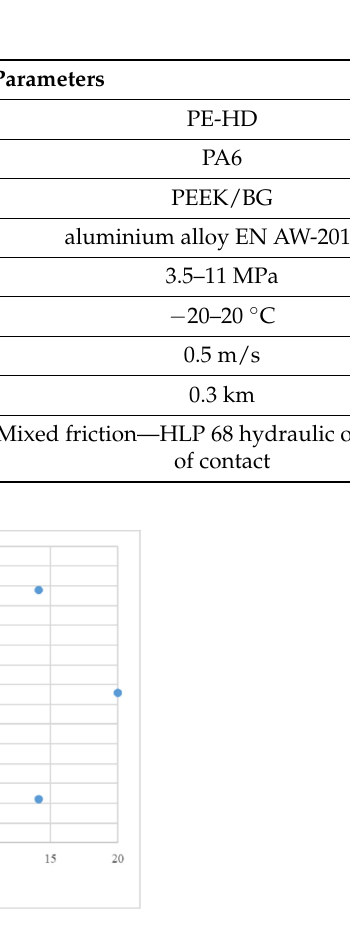
Figure 4. Distribution of measuring points for two variables ( T , p ).